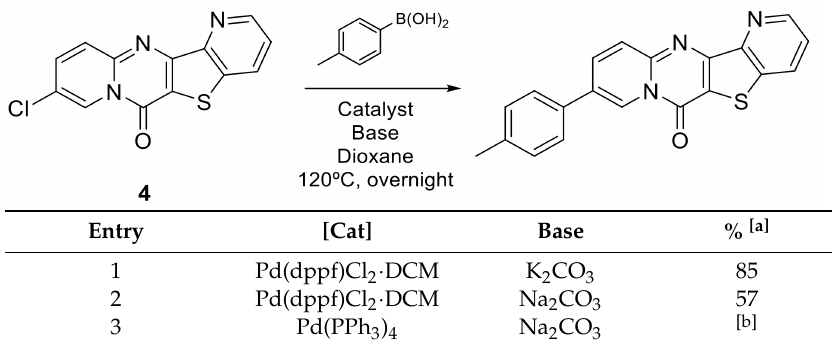
Table 2. Suzuki reaction optimization in